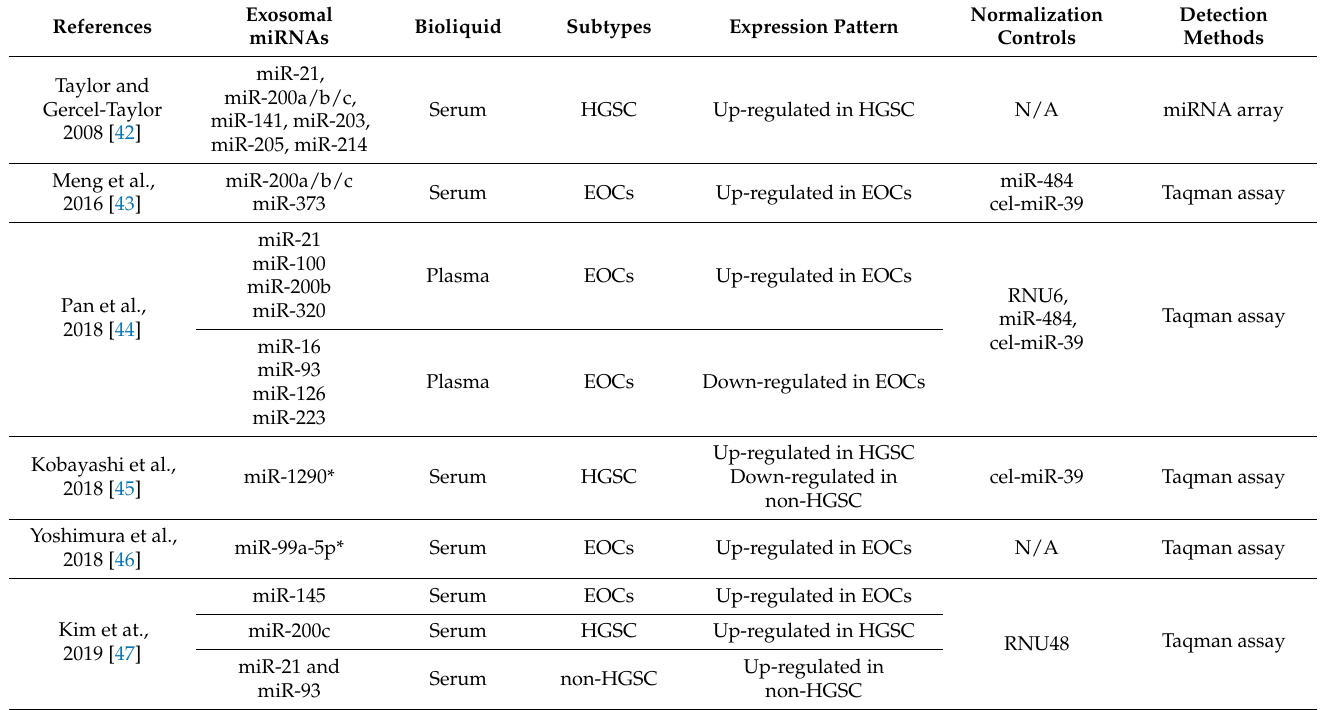
Table 1. Circulating exosomal miRNAs identified as potential diagnostic biomarkers in EOCs. N/A: not available, HGSC: high-grade serous